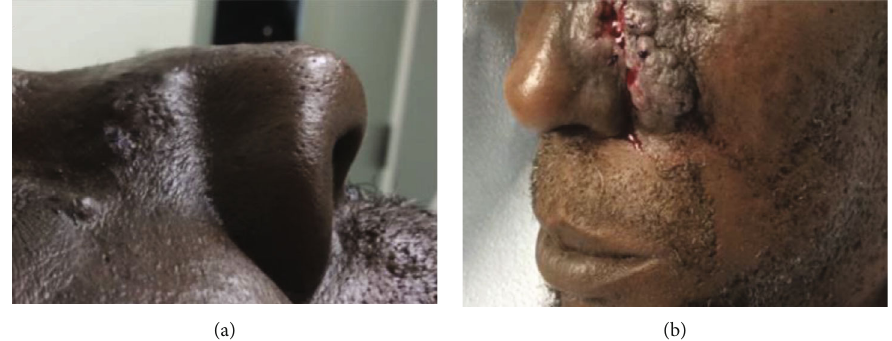
Figure 1: (a) Right nasal sidewall of patient ’ s angiosarcoma. (b) Left nasal sidewall of patient ’ s angiosarcoma.